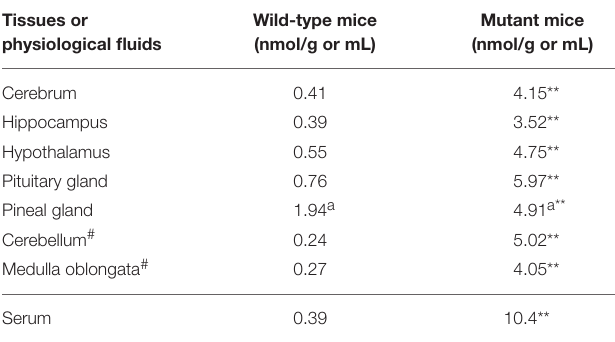
TABLE 5 | Amounts of D -leucine in the brain regions and serum of wild-type mice and mutant mice lacking DAO activity. Tissues or physiological fluids